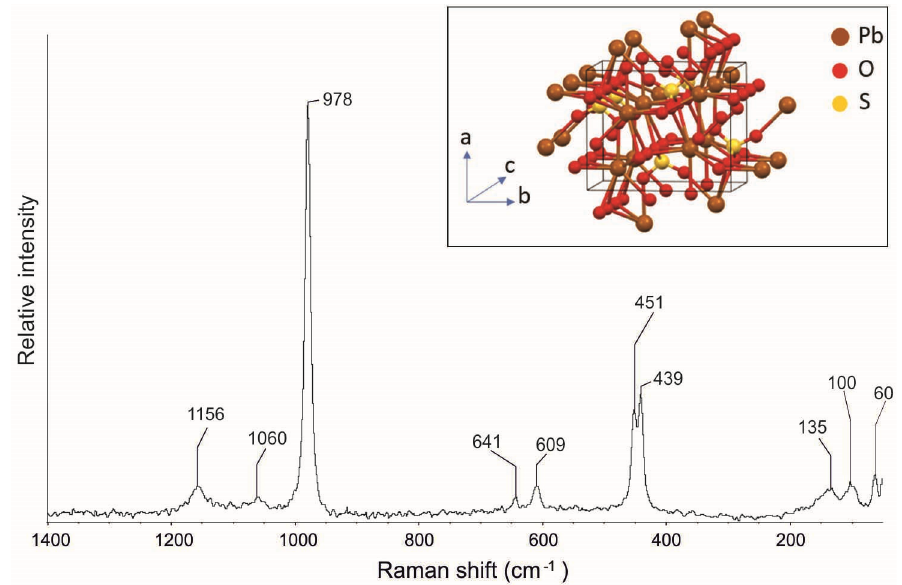
Figure 4. Raman spectrum of anglesite from the Mastricarro Barite Mine (Catanzaro, southern Italy). In the insert is the structure of the anglesite [25]. Table 1. Micro-Raman band wavenumber/cm − 1 for anglesite, cerussite, gypsum, langite, malachite, and posnjakite crystals from the Mastricarro Barite Mine (Catanzaro, southern Italy). The list shows observed Raman bands previously reported in the literature [28–43] and in the RRUFF database [39], as well as those here identified for the first